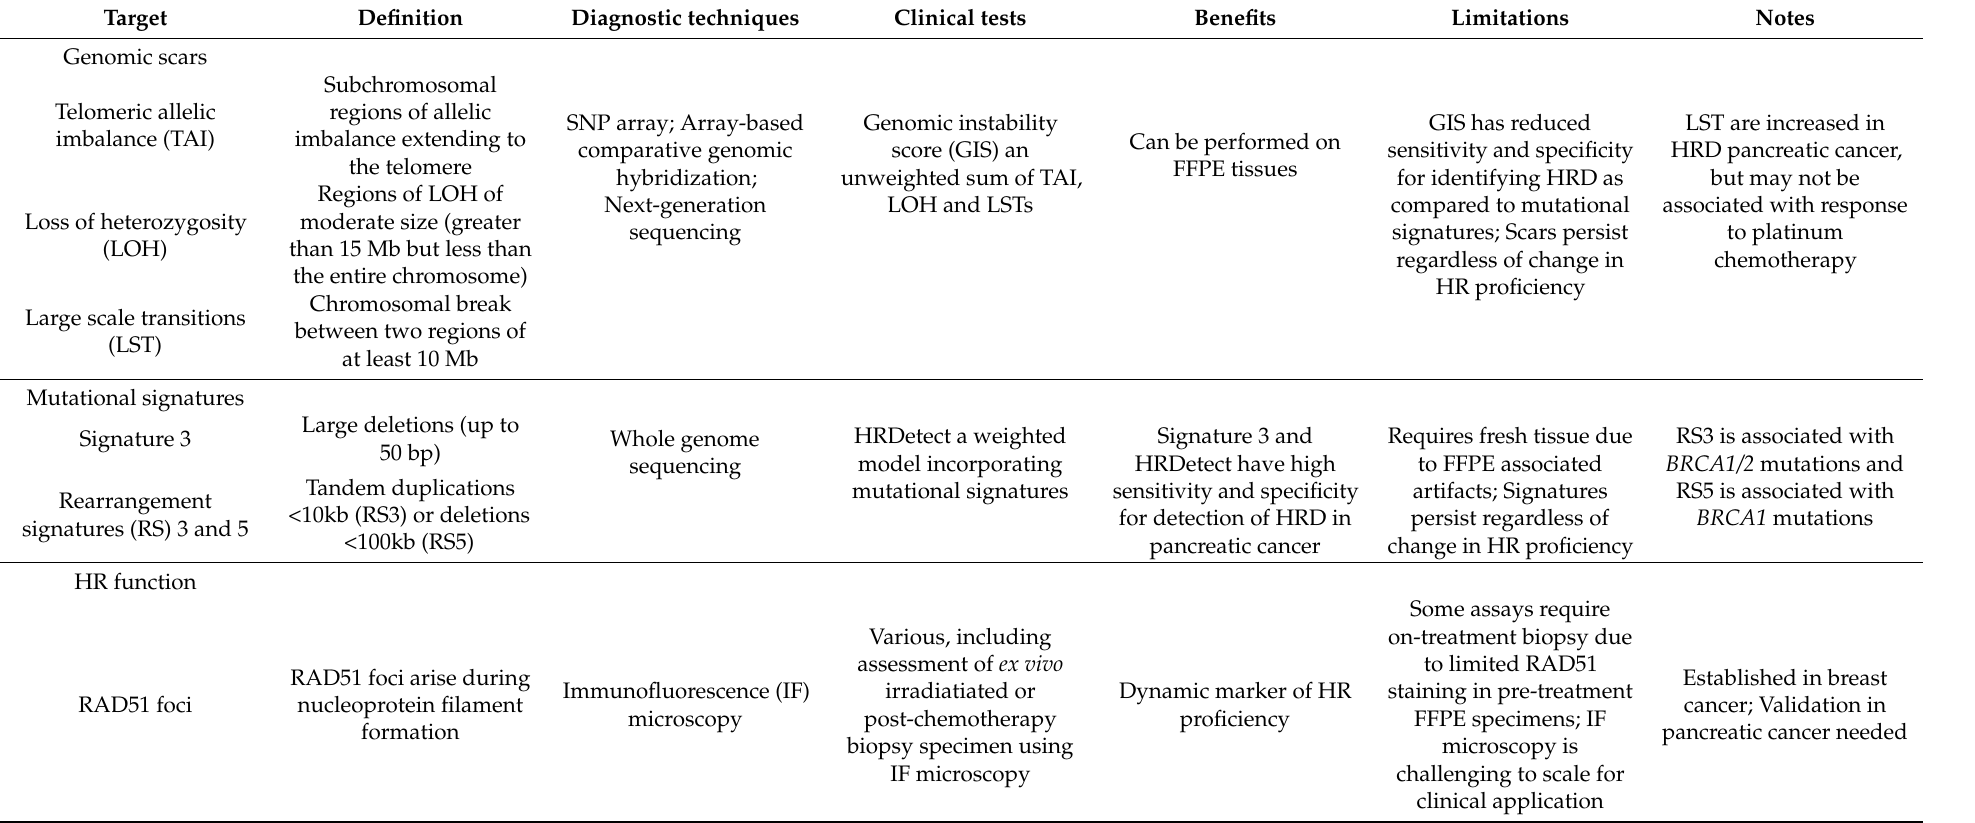
Table 2. Testing for homologous recombination